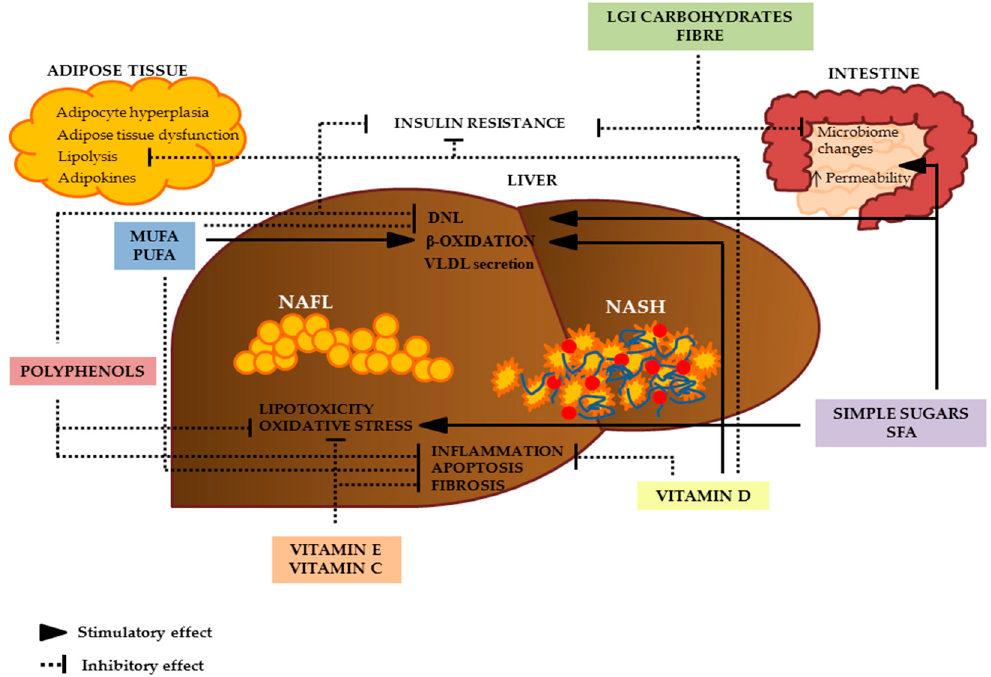
Figure 2. Possible sites of action of dietary nutrients in the nutritional treatment and prevention of NAFLD. Nutrients and dietary composition can modulate many key aspects in the pathophysiology of NAFLD: simple sugars promote DNL, produce inflammation and activate cellular stress pathways.